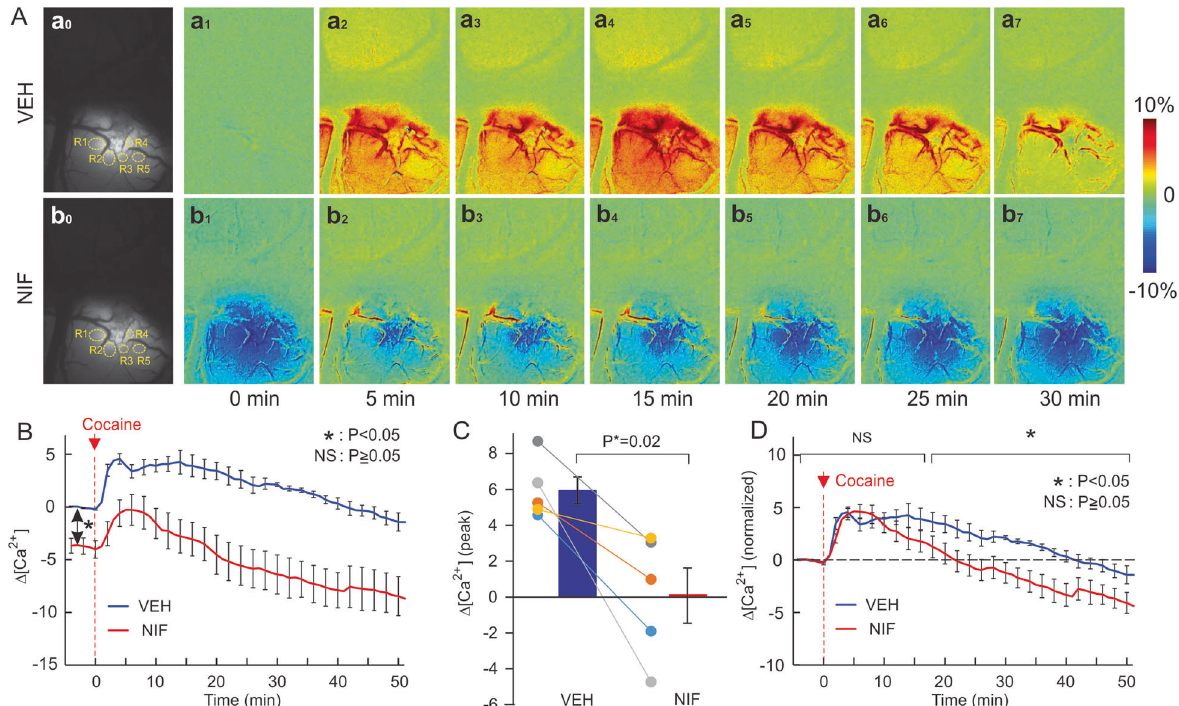
Fig. 1 Prefrontal neuronal [Ca 2 + ] i fl uorescence in response to cocaine challenge with or without NIF pretreatment. A Representative [Ca 2 + ] i fl uorescence images showing the spatial and dynamic changes in response to cocaine (1 mg/kg, i.v.) in PFCs after vehicle pretreatment (VEH, upper panel) and NIF-pretreatment (NIF, lower panel); It shows that NIF lowered baseline levels of Ca 2 + activity even after cocaine. B Averaged dynamic changes for cocaine-induced [Ca 2 + ] i fl uorescence without (VEH) and with NIF pretreatment (0.5 mg/kg, i.v., NIF). C Comparison of mean peak changes in neuronal [Ca 2 + ] i fl uorescence (i.e., Δ [Ca 2 + ] i ) triggered by cocaine between vehicle and NIF pretreatment alongside the individual values for each animal ( n = 5), showing the signi fi cant attenuation by NIF. D Averaged normalized dynamic change in [Ca 2 + ] i following cocaine with vehicle and NIF pretreatment at time t = 0 min. Values in graphs correspond to mean and standard errors. ROIs: the regions of interest in the tissue that did not have visible blood vessels to minimize the light attenuation from blood passing through vessels. For each animal, fi ve ROIs were selected in the GCaMP6f-expressed regions. * p < 0.05; NS: not signi fi